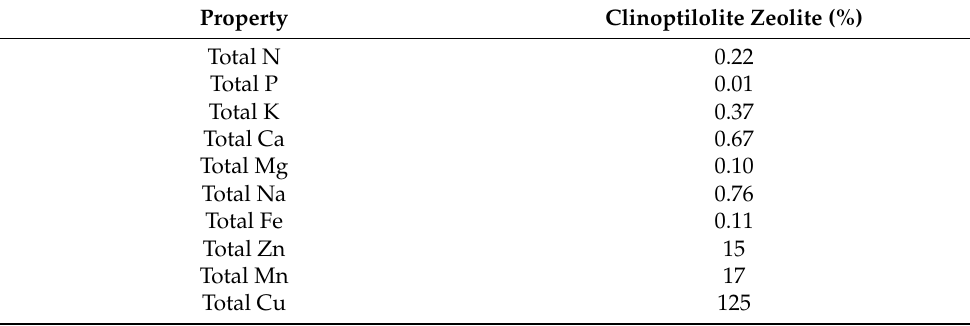
Table 2. Chemical composition of clinoptilolite